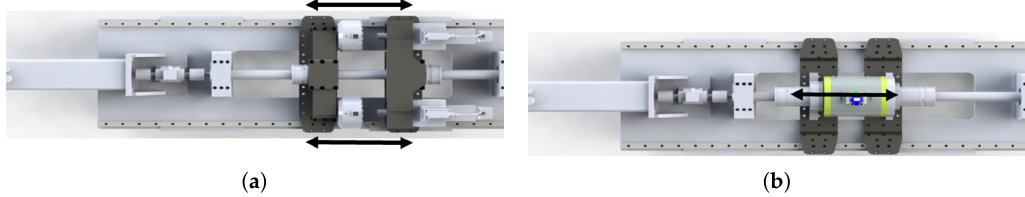
Figure 17. Functional schemes of loading systems through hydraulic actuators. ( a ) Two actuators in parallel. ( b ) Single central